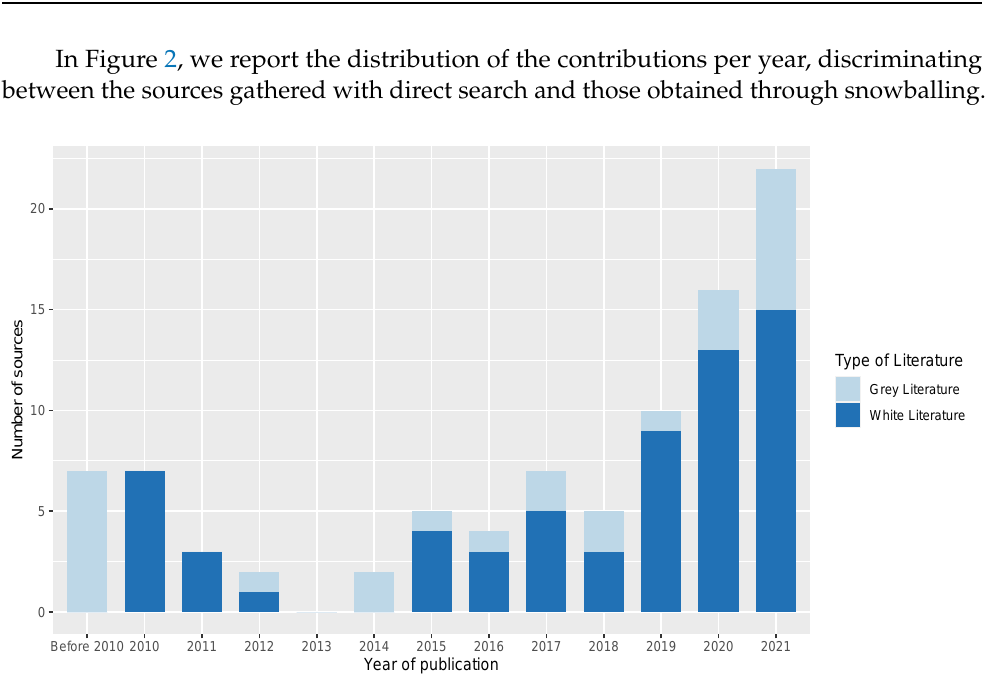
Figure 2. Amount of white and grey literature sources per